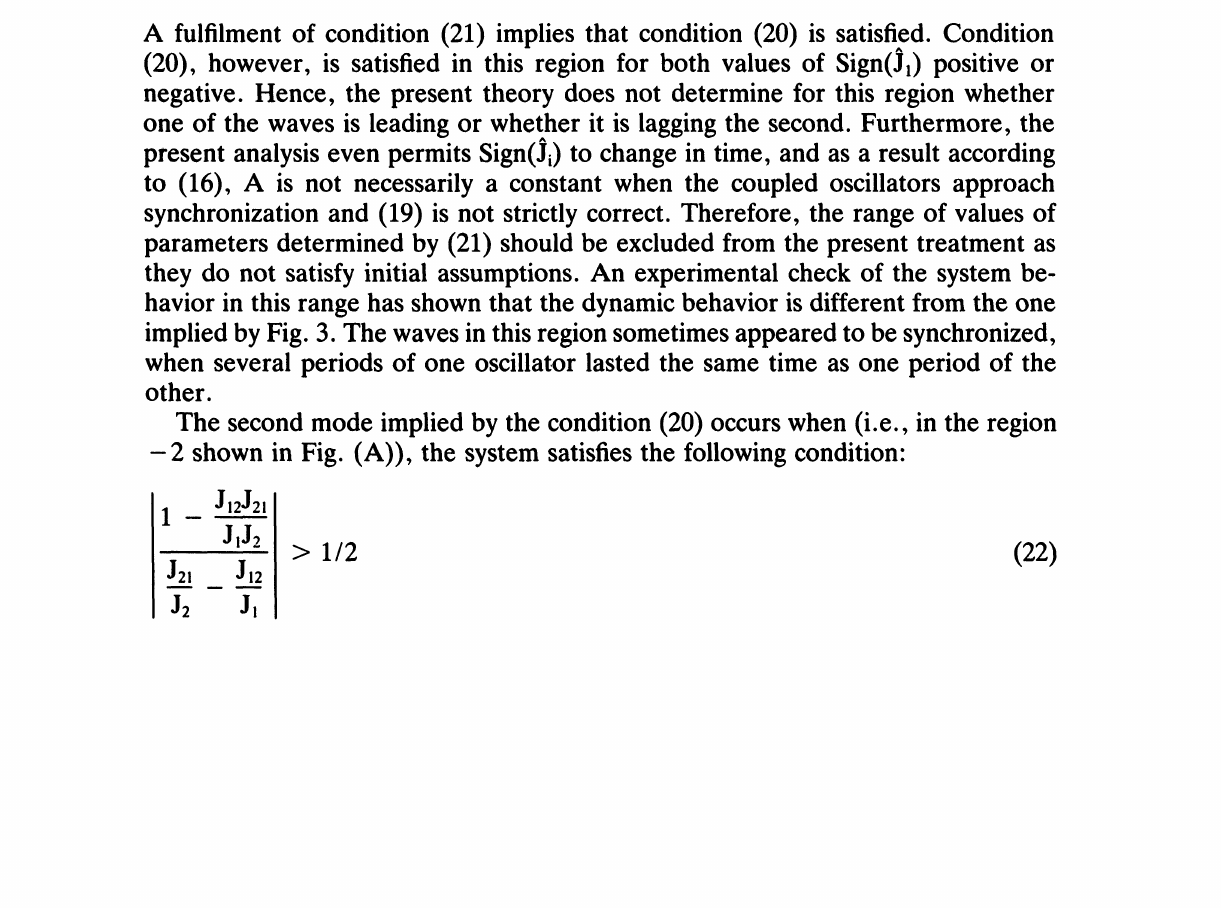
Ji + 1, i.e., 2 leads X then Q > -1/2. X2 lags XI Q when Sign J + 1 then Q <